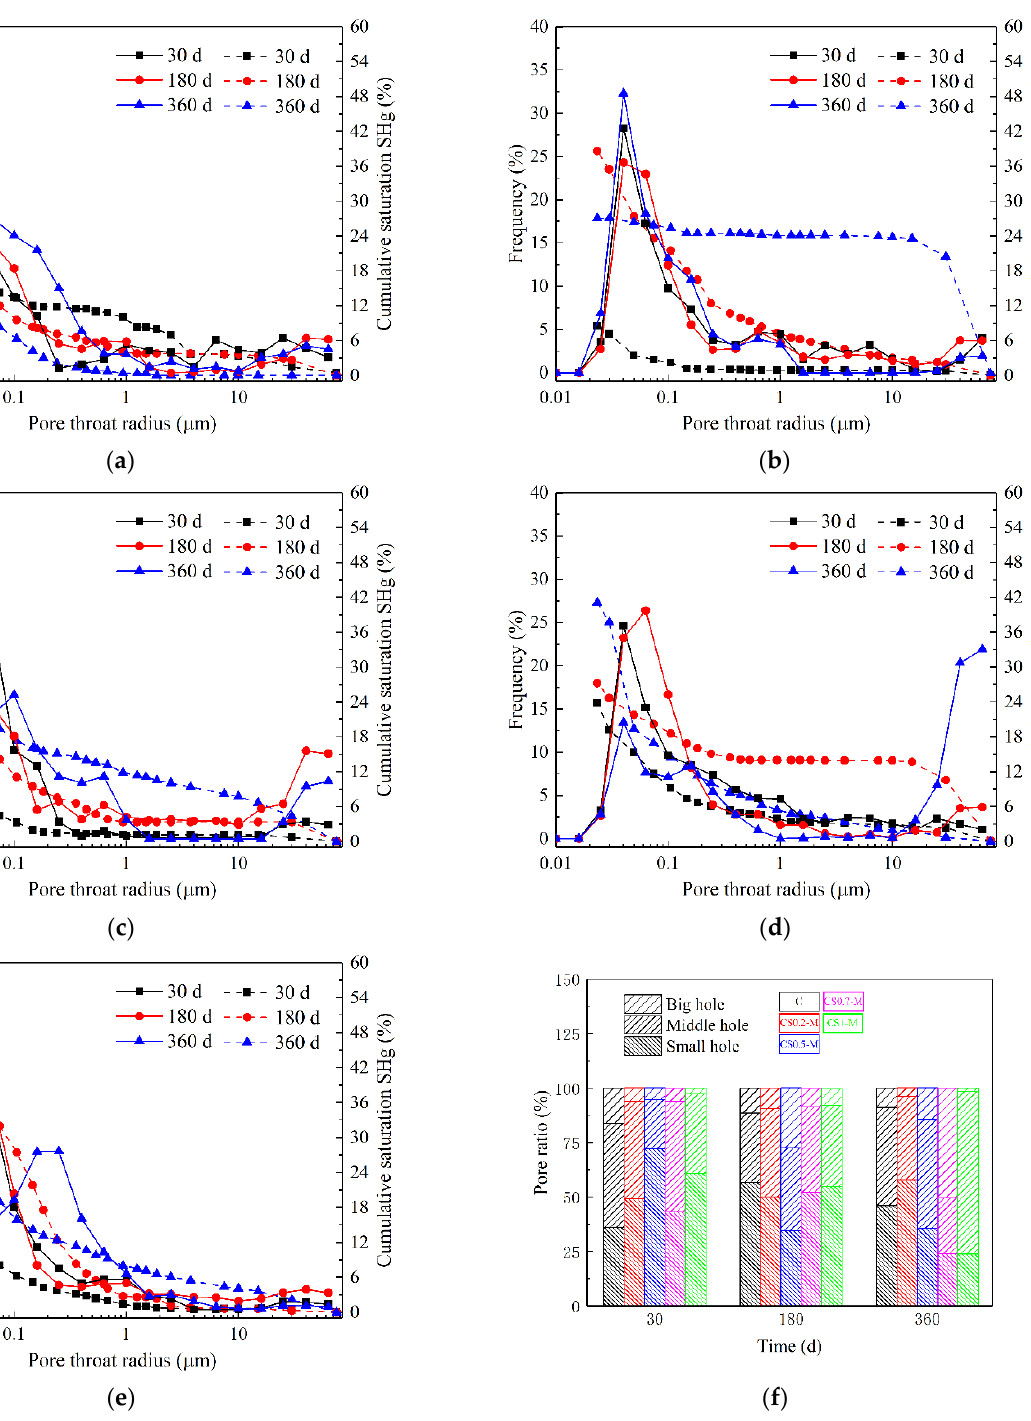
Figure 13. Pore distribution and cumulative mercury saturation of samples etched by NaCl-MgSO 4 solution: ( a ) C; ( b ) CS0.2-M; ( c ) CS0.5-M; ( d ) CS0.7-M; ( e ) CS1-M, and ( f ) porosity ratio map.